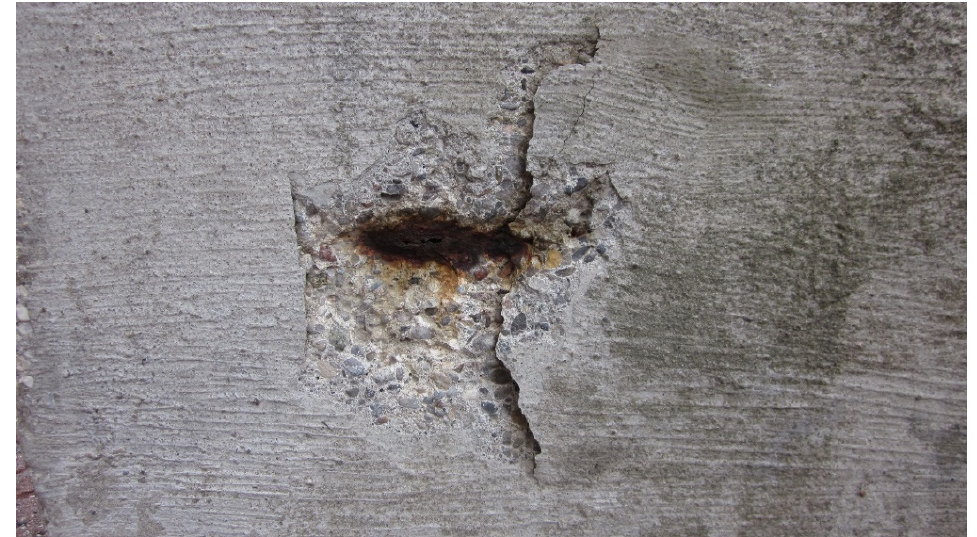
Figure 4. Cracking and spalling of concrete due to rebar corrosion.